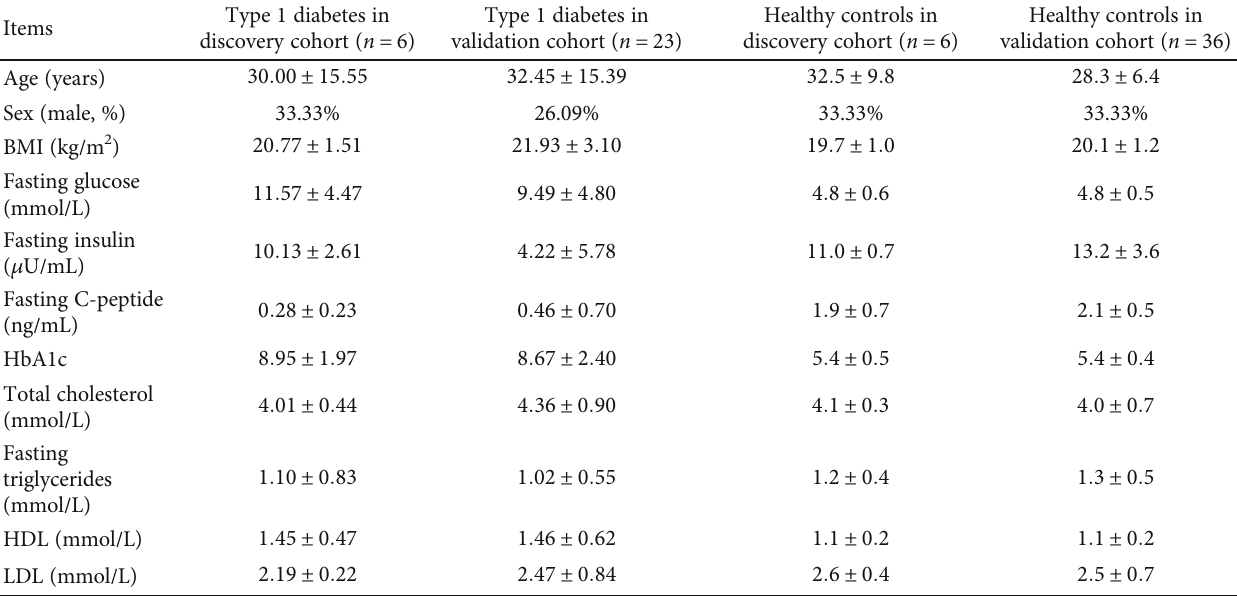
Table 1: Clinical characteristics of type 1 diabetes (T1D) patients and healthy controls in the discovery and validation cohorts.